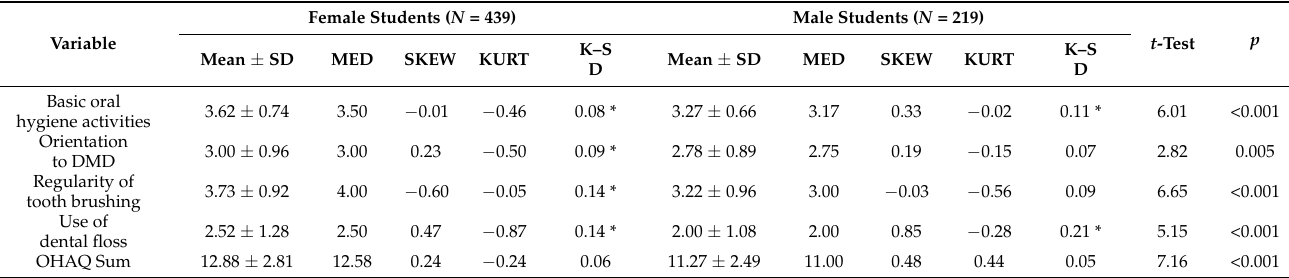
Table 3. Sensitivity and gender differences of OHAQ